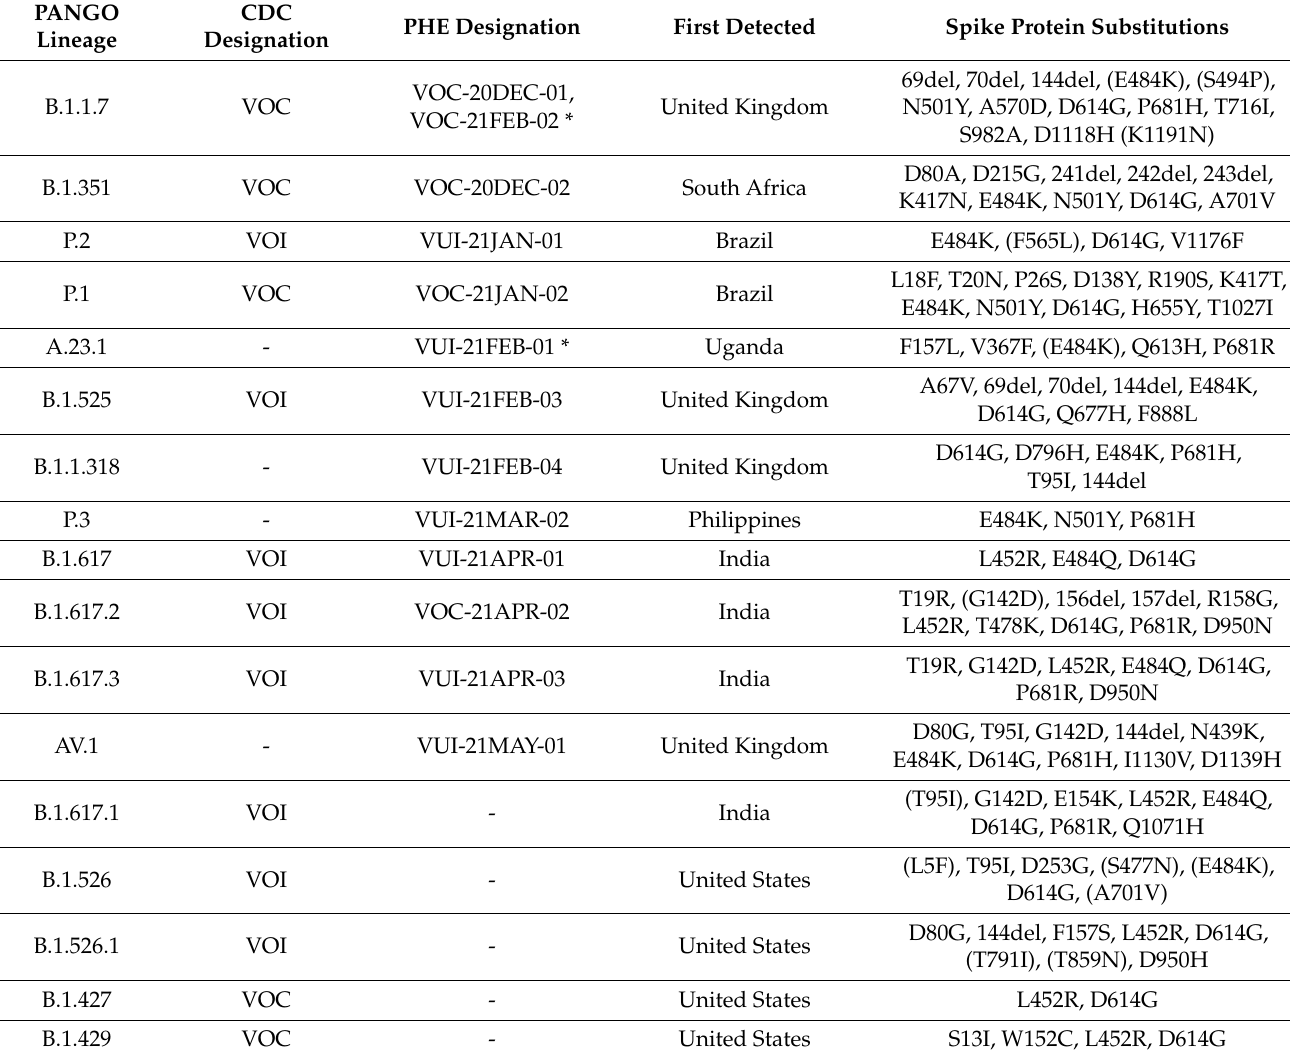
Table 2. Notable variants of